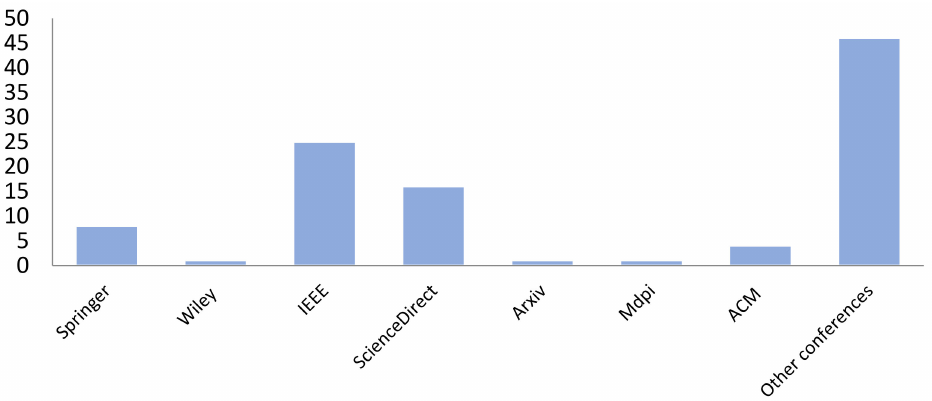
Figure 2. Number of papers selected from each academic